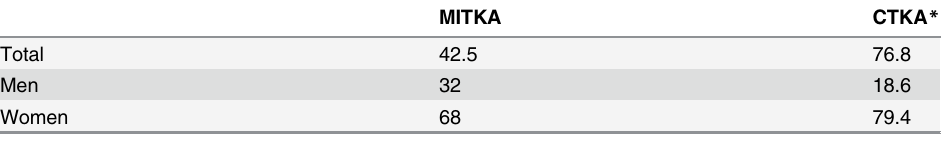
Table 2. Percentage of patients with delayed peak of CRP at day 4 in the two